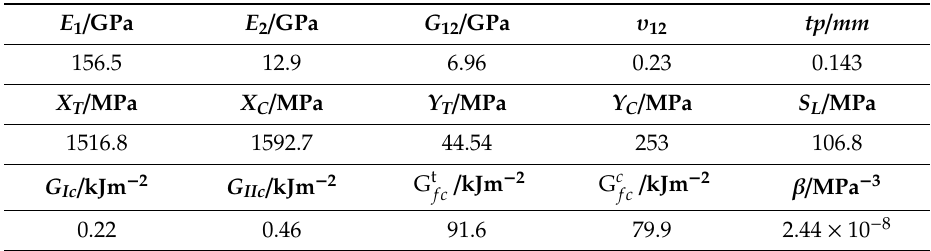
Table 4. Mechanical properties of material T300 / 976 [36,38].